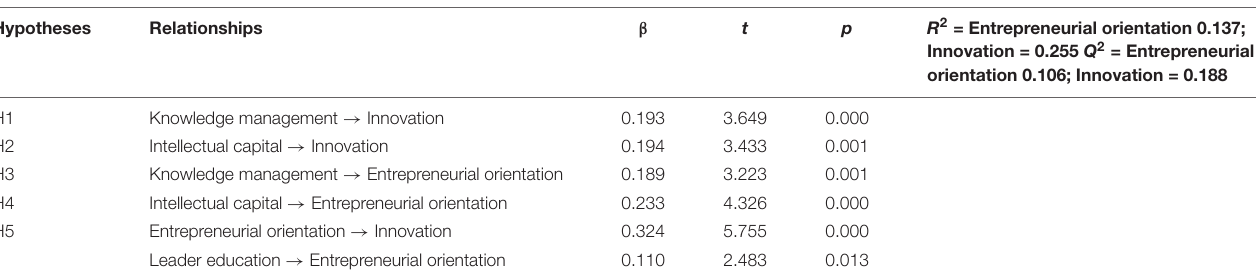
TABLE 5 | Path coefficients (direct